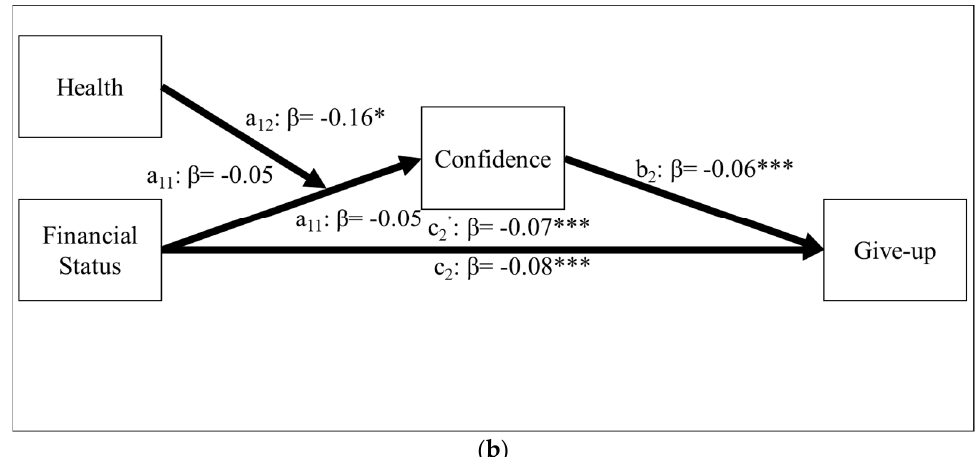
Figure 2. ( a ) Moderated mediation effect on active coping. ( b ) Moderated mediation effect on giving- up tendencies. Parameter estimates for moderated mediation analysis using healthiness as potential moderator after controlling for covariates. As ‘i’ denotes model number, a i1, a i2 , and a i3 indicate the direct effect of financial status on confidence, direct effect of health on confidence, and interaction effect between financial status and health on confidence, respectively, in both models. * p < 0.05. ** p < 0.01. *** p < 0.001.